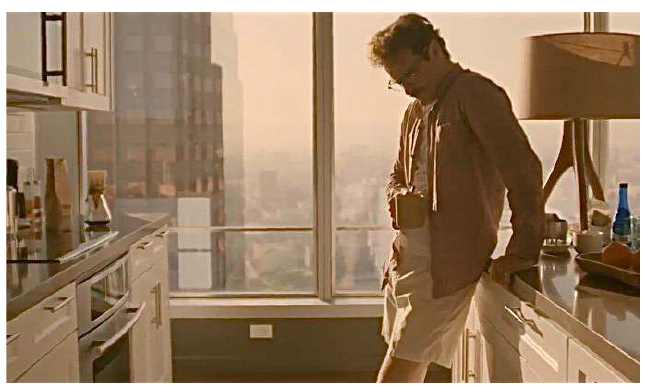
Figure 3. Theodore was unable to